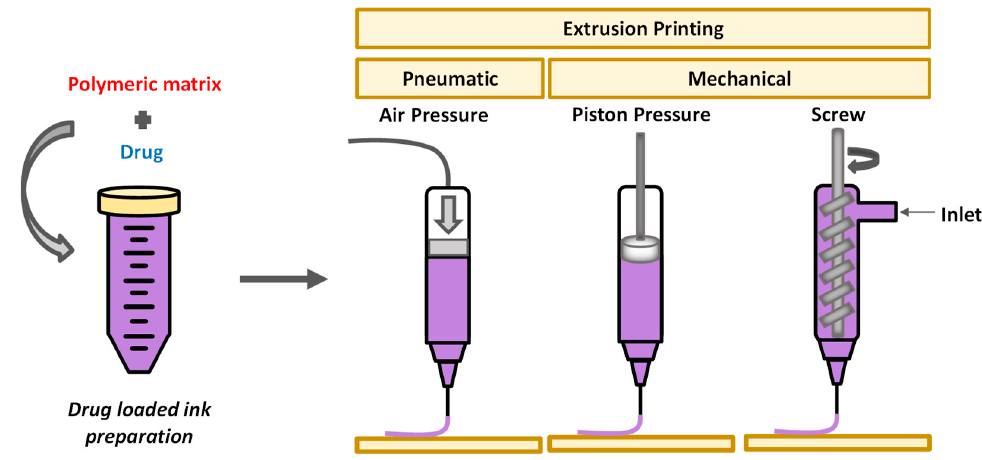
Figure 4. Extrusion-based printing systems.